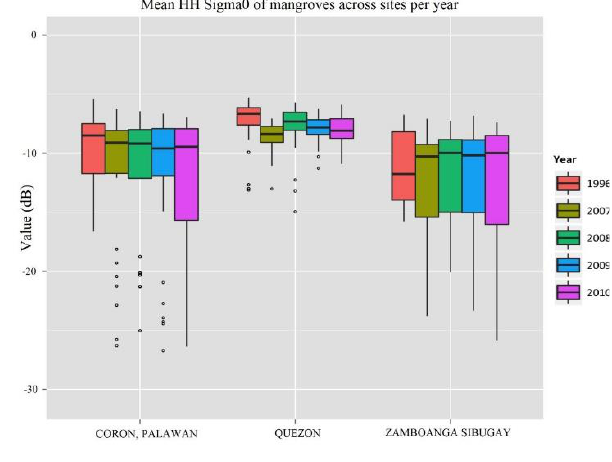
Figure 2. Mean backscatter values of the ground truth data collected from all three sites (Palawan, Quezon and Zamboanga Sibugay) comparing mangroves and non-mangroves in (top) HH and (bottom) HV polarisations. The graphs in Figure 2 show the mean backscatter values of the mangrove areas found in the three study sites per year. Overall, it is observed that the HH polarisation shows higher backscatter responses (-16 to -7 db) with more variations in the mean values extracted per year as compared to the HV polarisation. The backscatter values from the HV polarisation show low backscatter responses (-22 to -12 db) and stable mean values across the years. Although all locations where these values were extracted all pertain to mangrove areas, it can also be observed that the mean backscatter values were noticeably distinct, occupying a certain range of values for each site.